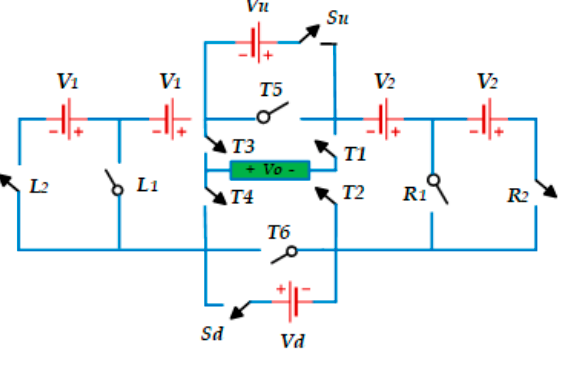
Figure 2. 35 − Level